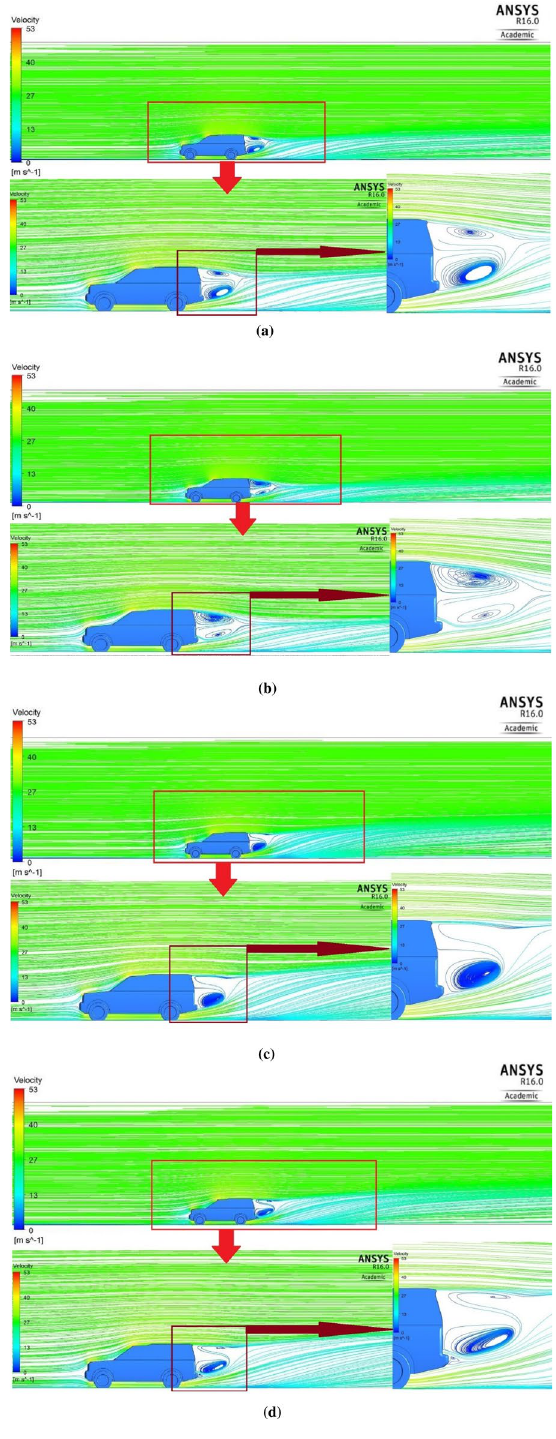
Figure 13. (a) Streamline around the baseline of the Land Rover Discovery. (b) Streamline around the Land Rover Discovery with the ventilation duct. (c) Streamline around the Land Rover Discovery with roof modification. (d) Streamline around the Land Rover Discovery with the ventilation duct and roof